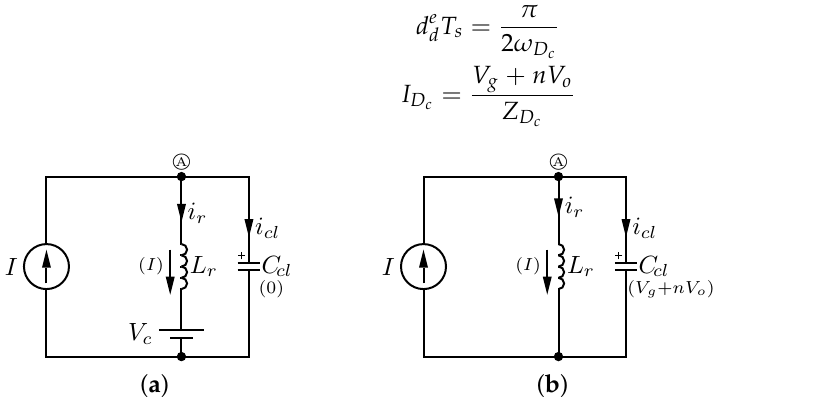
Figure 8. Equivalent circuits: ( a ) during time interval 3; ( b ) during time interval 9. The initial conditions are in